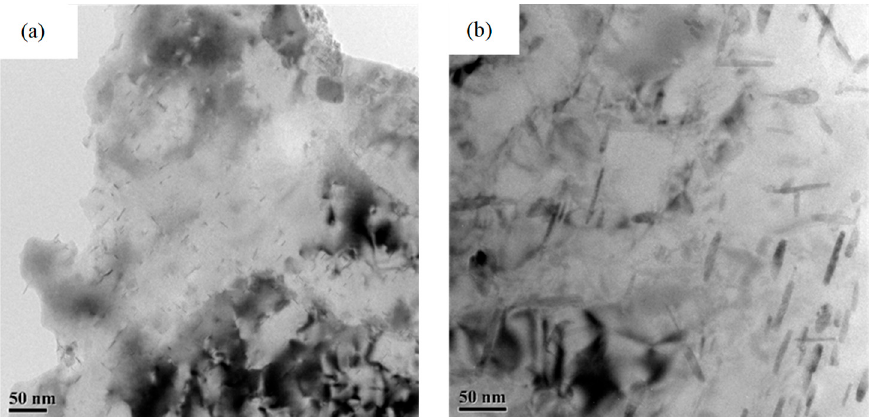
Figure 9. TEM micrographs of two kinds of precipitates in 25Cr3Mo3NiNb steel after tempering at 640 °C.